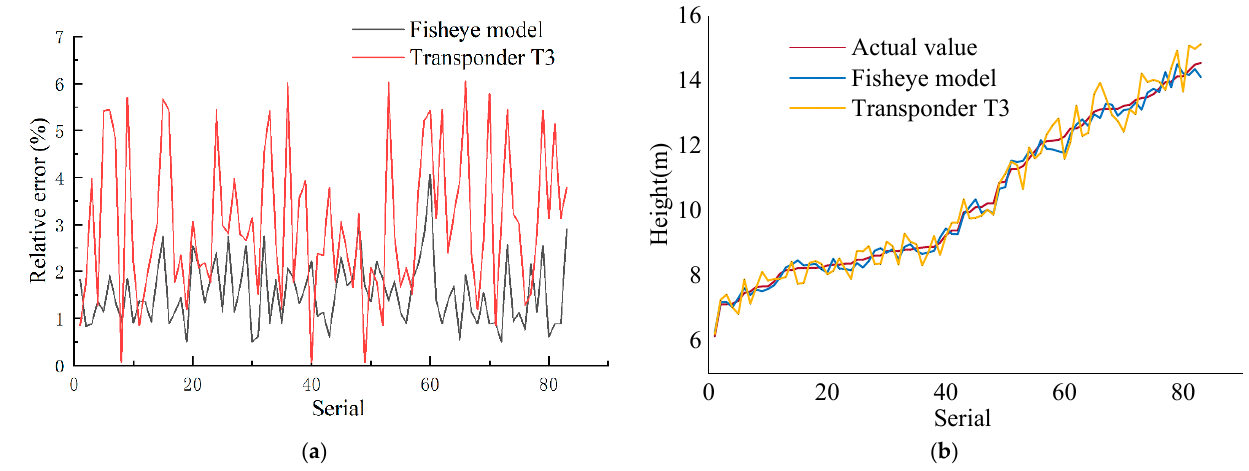
Figure 12. Measurement results. ( a ) Measurement Error; ( b ) Measured value.